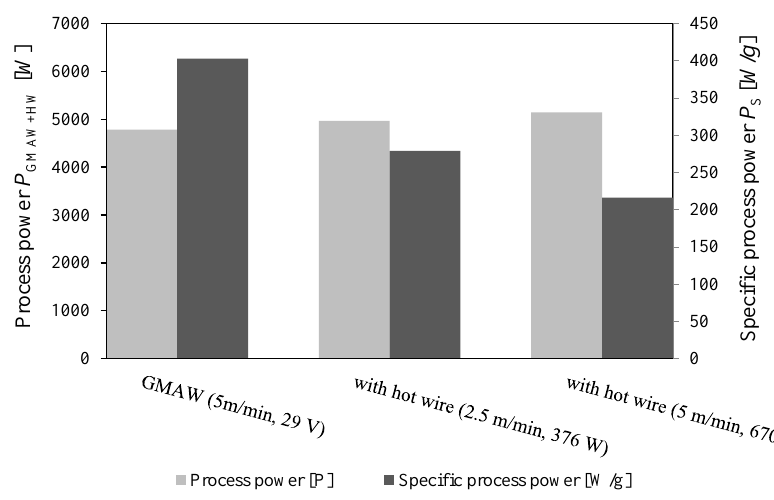
Figure 5. Influence of an additional hot wire (HW) on the process power, P GMAW+HW , and specific process power, P S , during GMAW.